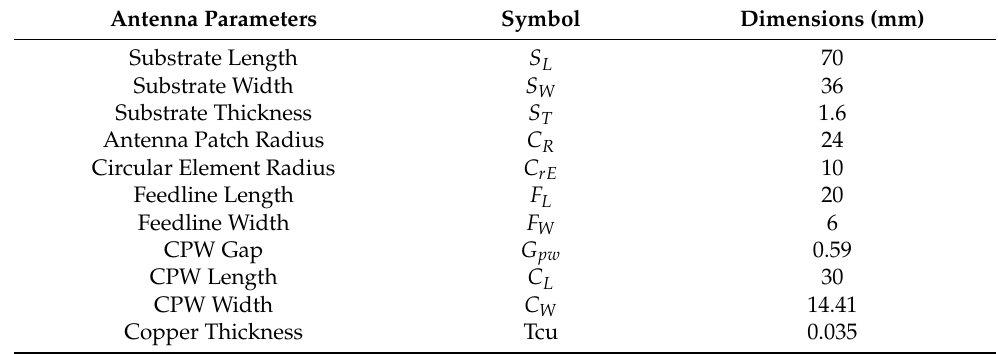
Figure 1. Trefoil antenna: ( a ) CST simulation model, ( b ) fabricated, ( c ) encapsulated in PDMS. Table 1. Dimensions of Trefoil Antenna.